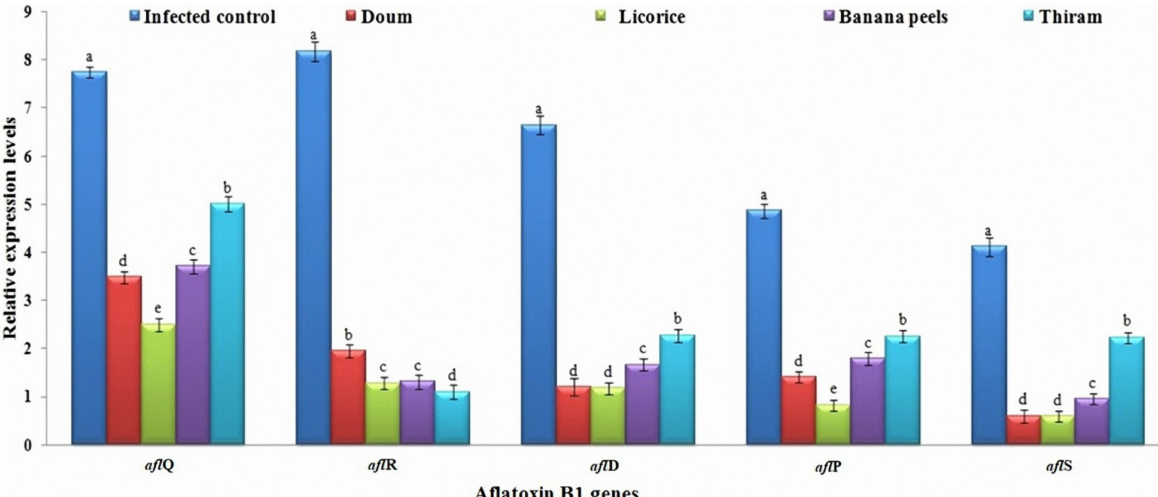
Figure 2. The relative expression levels of structural ( afl D, afl P, and afl Q) and regulatory genes ( afl R and afl S) of the aflatoxin B1 (AFB1) biosynthetic pathway in maize grains treated with doum, licorice, banana peel extracts, and Thiram fungicide before the Aspergillus flavus Af1 inoculation. Columns with the same letters among each gene are not significantly different at p ≤